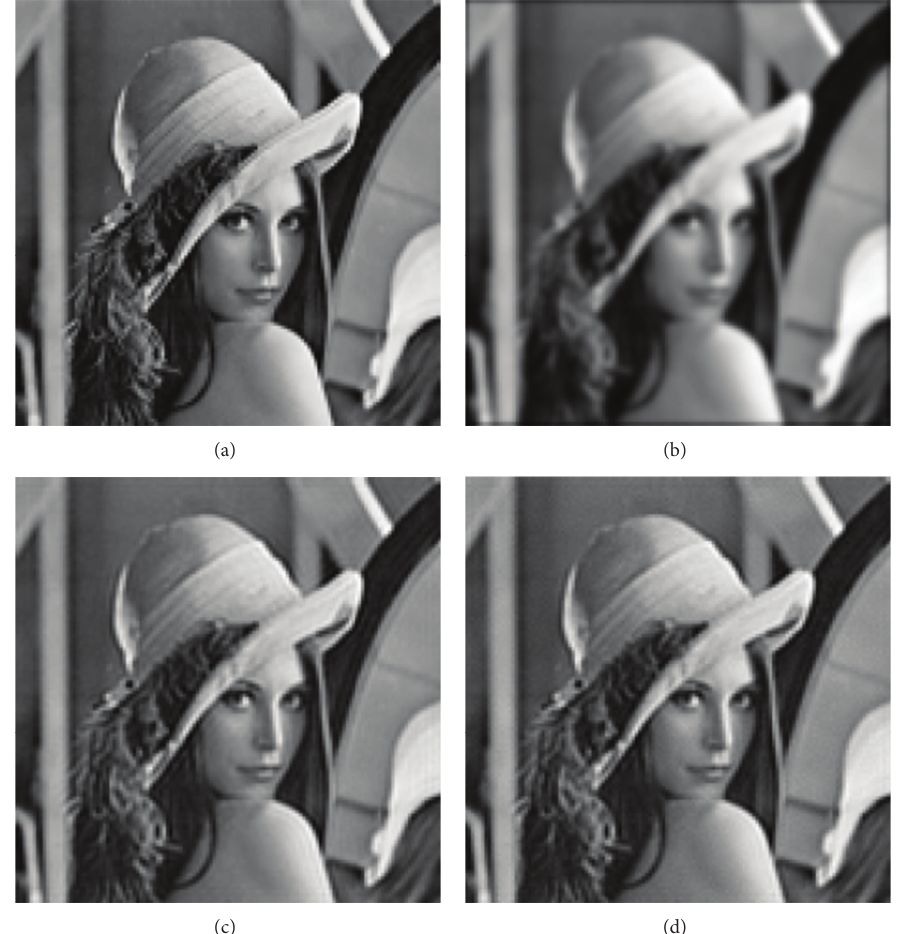
Figure 1: (a) True image, (b) blurred and noisy image with 𝜎 = 1 , (c) restored image with LSQR, and (d) restored image with IDR(1).